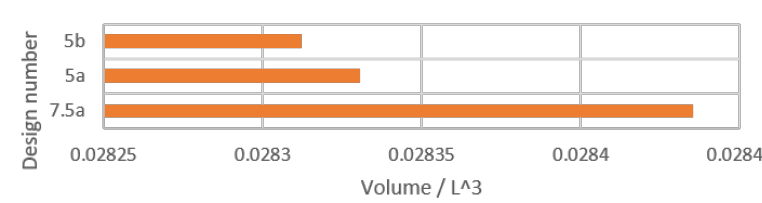
Figure 9. Value of non-dimensional volume for designs with appendage